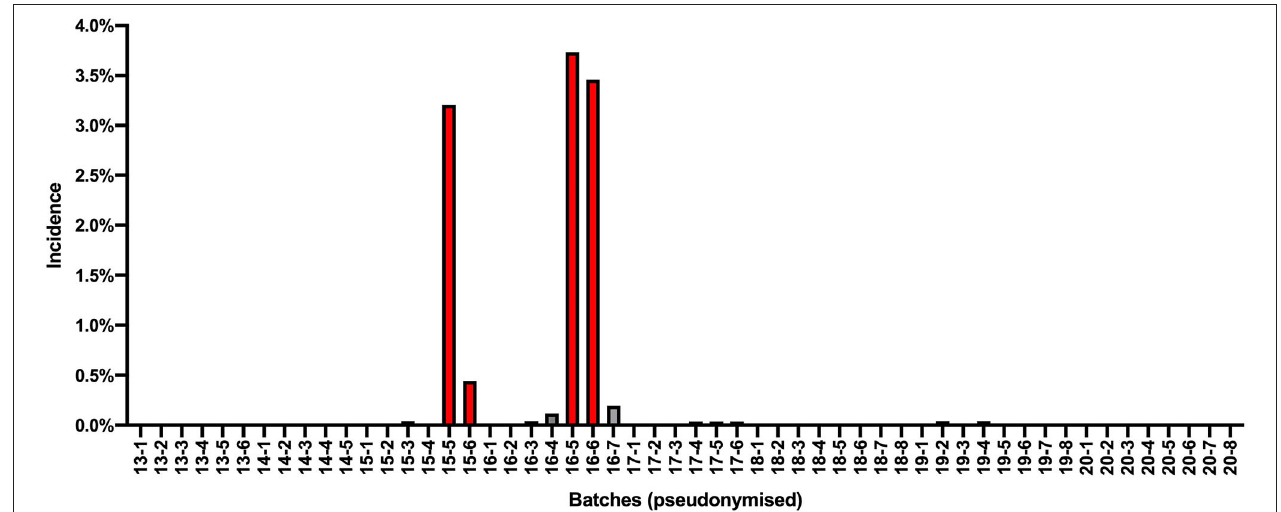
FIGURE 2 | Incidence of adverse events in horses (number of reacting horses per calculated number of treated horses in %) received 2013–2020 displayed per batch. Batch numbers are pseudonymised. Incidences of conspicuous batches are highlighted in red. Sales volumes of these batches are lower due to safety measures (recall, marketing stop). Incidences of inconspicuous batches are denoted in blue. Batch 15–6: sales volume was very low due to recall together with batch 15–5. In one report, the batch number is unknown, this case is not included. In four adverse event reports of five horses, it was unclear which of the two batches (16–5 and 16–6) was used; thus, for incidence calculation, three horses were assigned to 16–5 and two were assigned to 16–6. Batches 15–3, 16–4, and 16–7: uncertainty if stated batch number is correct in one horse each. In one report, the horse received batch 19–2 mixed with batch 18–4; for incidence calculation, the case was assigned to batch 19–2